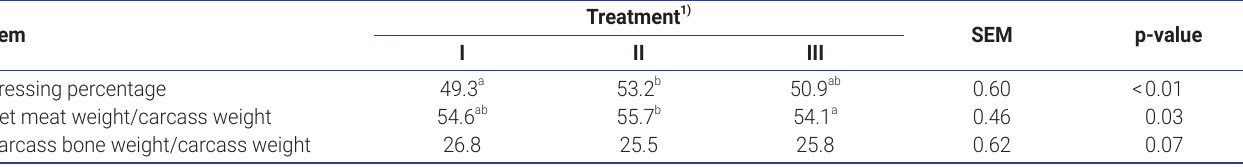
Table 3. Effect of dietary GAA and RPM supplementation on carcass traits of lambs